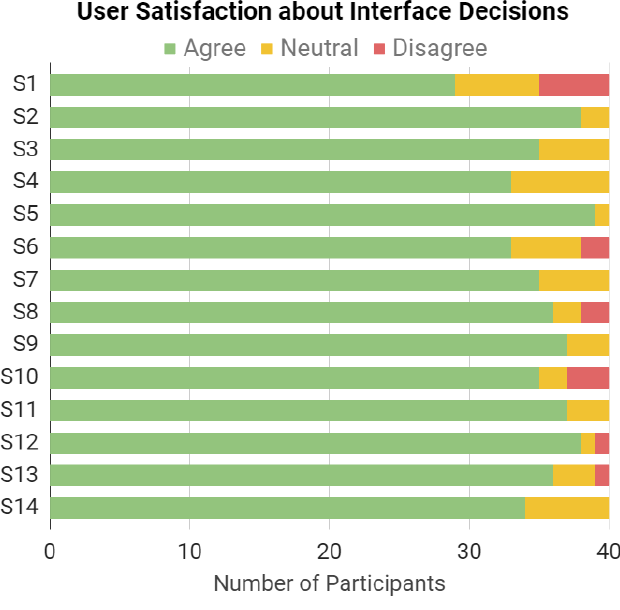
Figure 10. Summary of results from questions related to the user satisfaction about interface design decisions. The complete sentences and percentages can be observed in Table II in the Appendix.